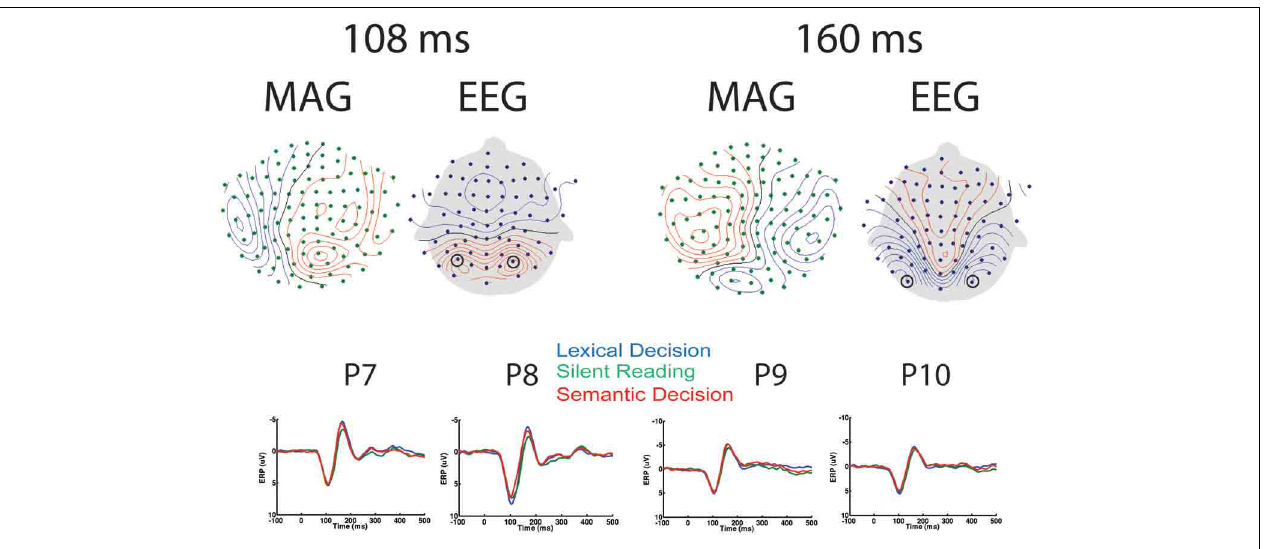
FIGURE 2 | EEG/MEG results in sensor space. Left: Topography of EEG and Magnetometers (MAG) for All-word > Baseline contrast at 108ms (P1), as well as time courses for peak electrodes (P7 and P8). Right : Topography